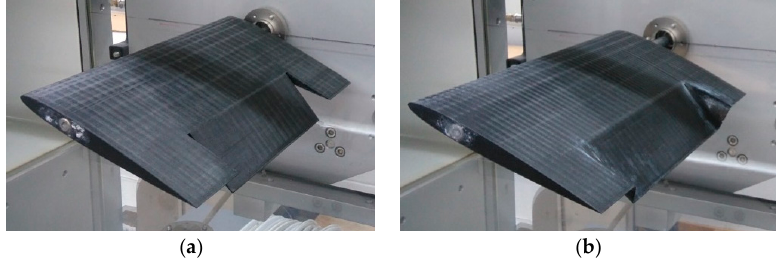
Figure 1. ( a ) The finished 3D printed conventional wing aerofoil model; ( b ) The finished 3D printed optimized morphing aerofoil model.